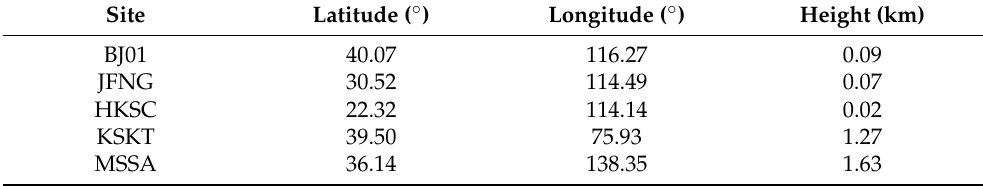
Table 5. Locations of the five stations selected in the simulated kinematic PPP-B2b experiment.